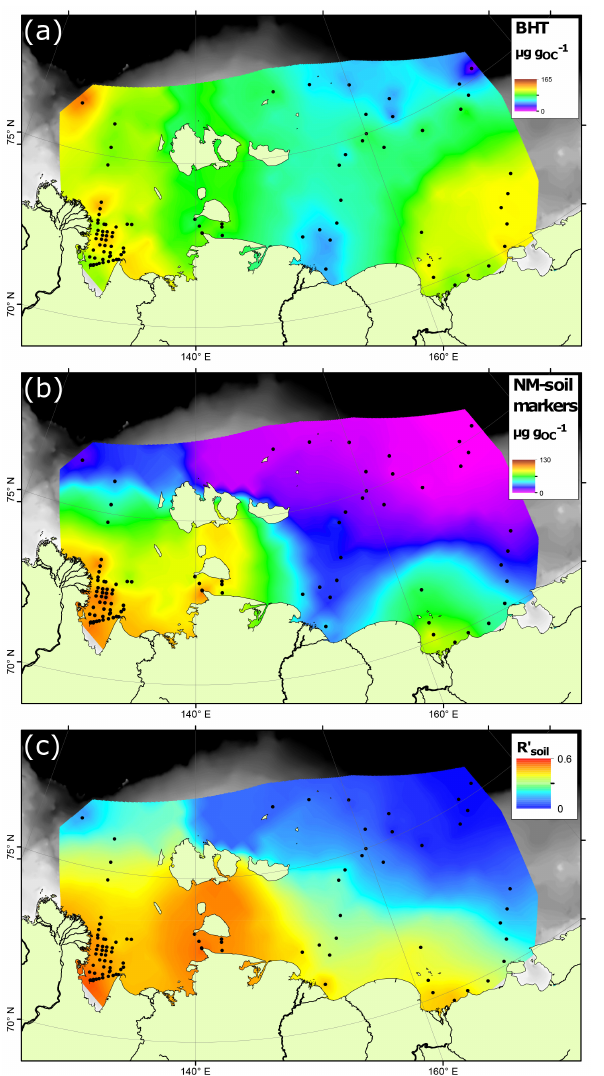
Figure 2. Maps of (a) BHT and (b) summed non-methylated soil marker concentrations (µgg − 1 ) and (c) the resulting R (cid:48) soil in ISSS OC sediments from the ESAS. Maps were interpolated using a kriging Figure 3. Box plots summarising the concentrations of (a) BHT, (b) algorithm (ArcGIS v.10; ESRI Ltd) and the locations of the ISSS-08 summed non-methylated soil markers and (c) the resulting R (cid:48) soil on stations are shown as black dots. the ESAS, grouped by distance from river mouths. Concentrations in ice complex samples are also shown (see Fig. 1 for locations). Thick lines show the median values, boxes the 25th and 75th per- centiles, whiskers the maximum and minimum values within 1.5 times the interquartile range, and circular symbols outliers beyond this